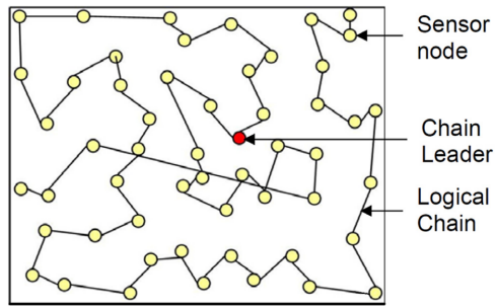
Figure 4. Chain-based WSN (the color yellow is used to represent sensor nodes, whereas the color red is used to represent the chain